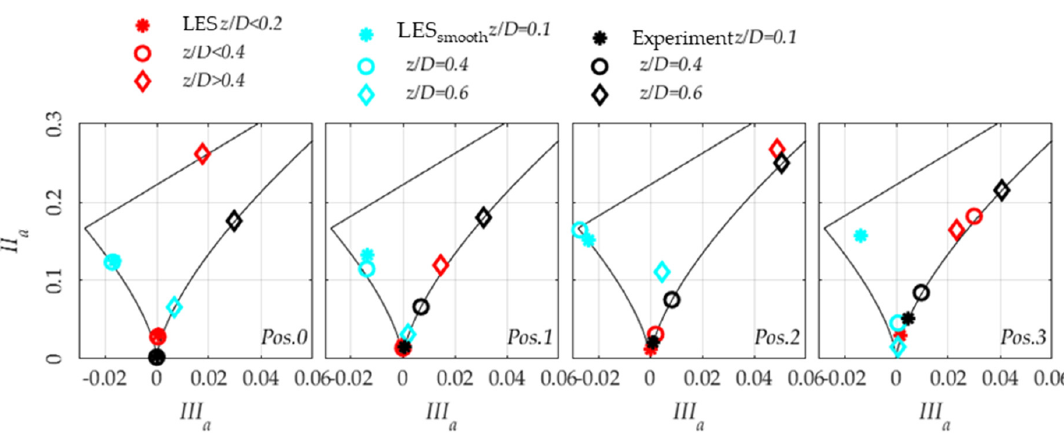
Figure 11. Velocity invariants for the assessment of flow anisotropy (LES with smooth and turbulent inlet conditions).